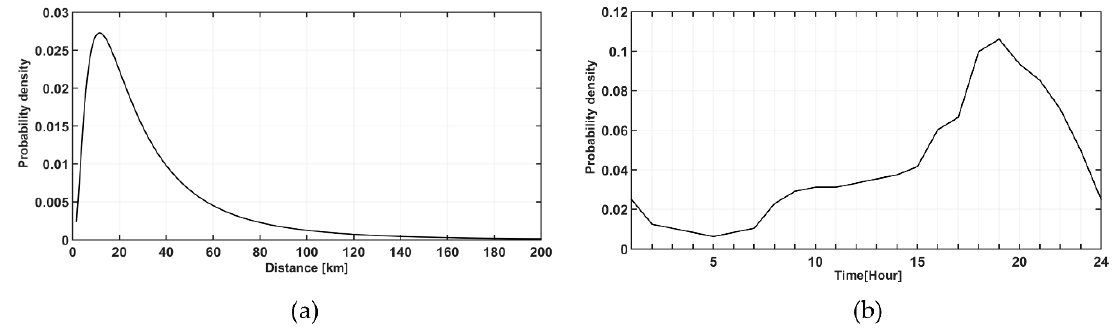
Figure 2. Probability Density Function (PDF) of variables: ( a ) daily drive distance; ( b ) vehicle arrival time.